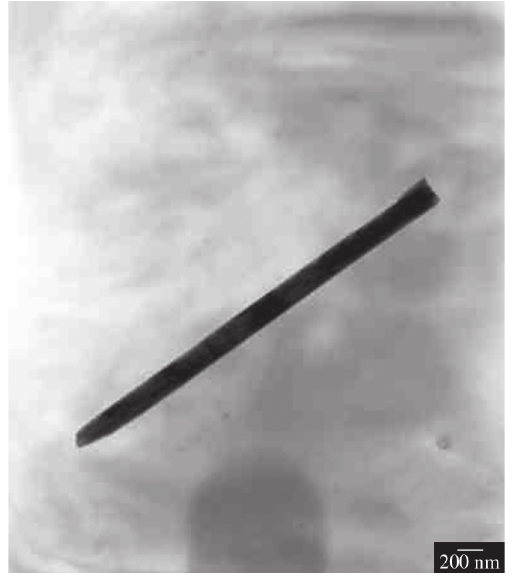
Figure 4. TEM micrograph of Co nanowires freed from the alumite film.